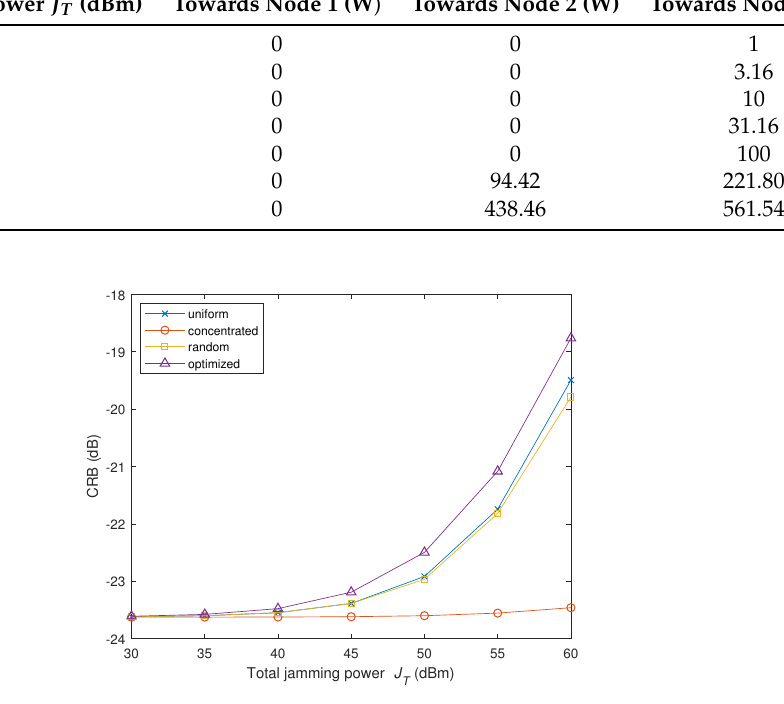
Figure 4. CRB of v x versus the total jamming power J T in the second experiment of Scenario